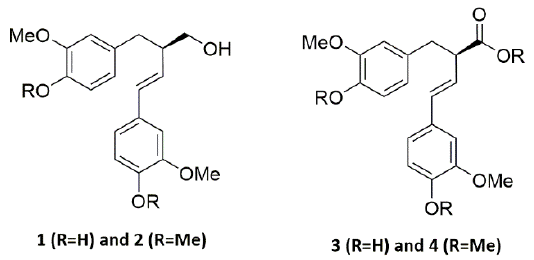
Figure 2. Imperanene ( 1 ), dimethyl-imperanene ( 2 ), Imperaneic acid ( 3 ), permethylated imperaneic acid ( 4 ).